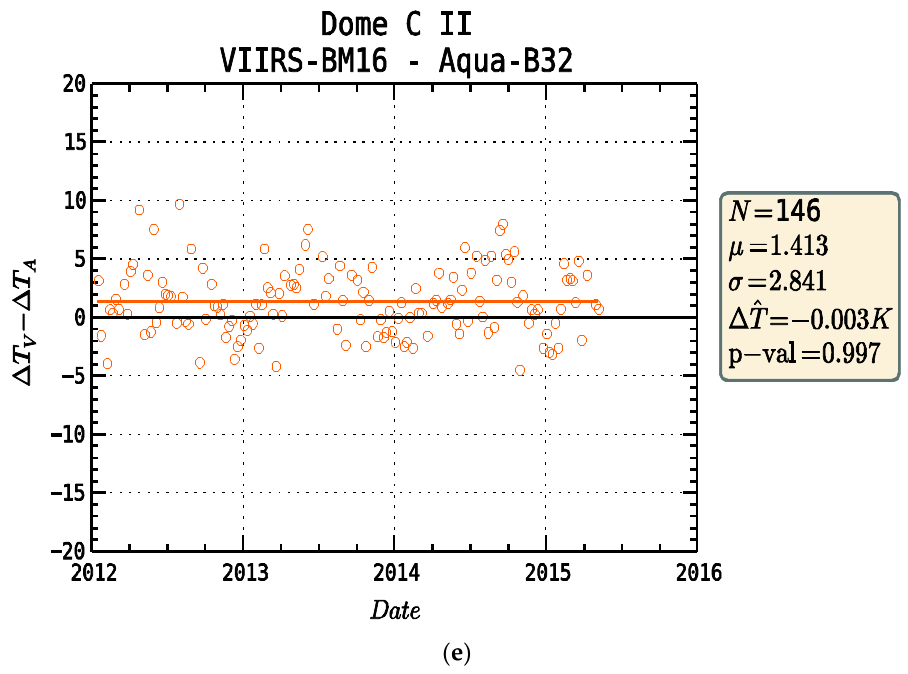
Figure 7. The 3.5-year relative bias trend between S-VIIRS and A-MODIS. ( a ) M12/B20; ( b ) M13/B22;